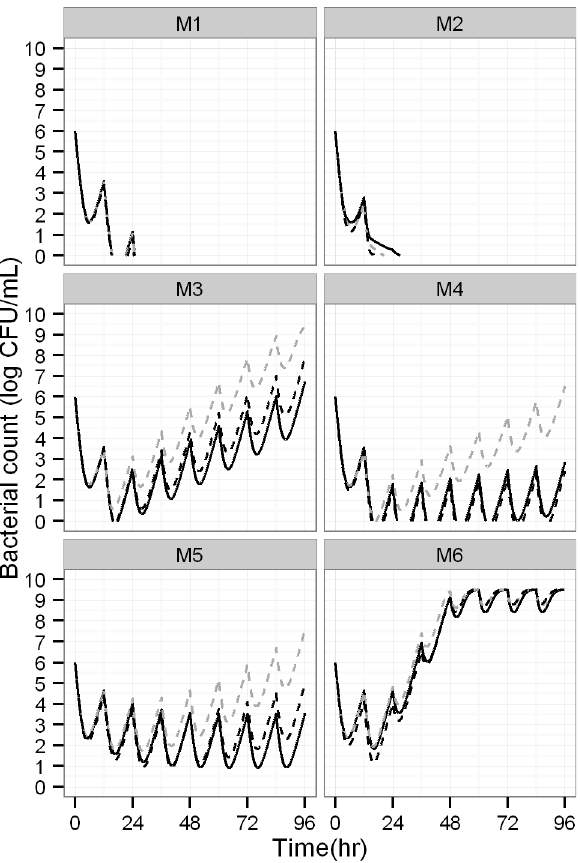
Fig 5. Simulated viable count profiles after multiple dosing under dynamic conditions for a hypothetical antibiotic with a 1 h elimination half-life and peak concentration of 8 x KC 50S . Simulations were based on the true parameter values (solid black lines) or parameter values estimated under dynamic (dashed black) or static conditions (dashed grey).